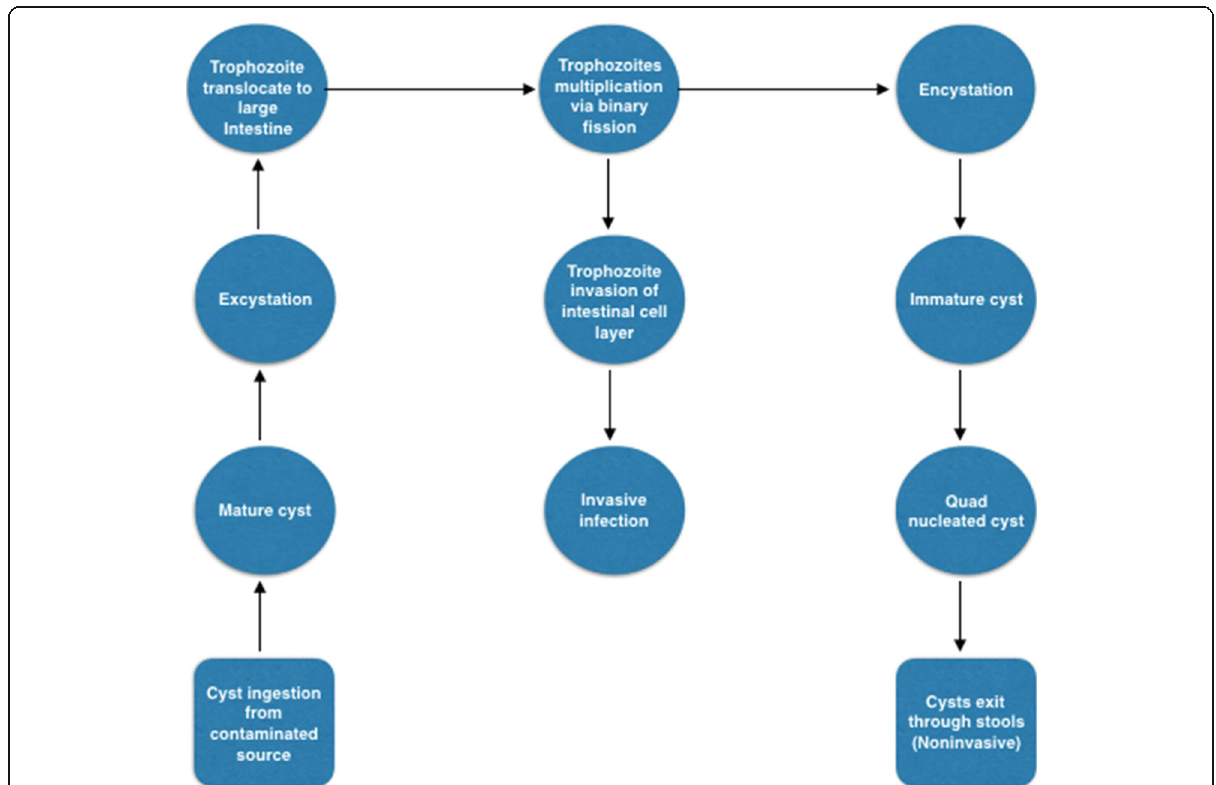
Fig. 1 Schematic representation of the pathogenesis of E. histolytica from ingestion to extra-intestinal hepatic